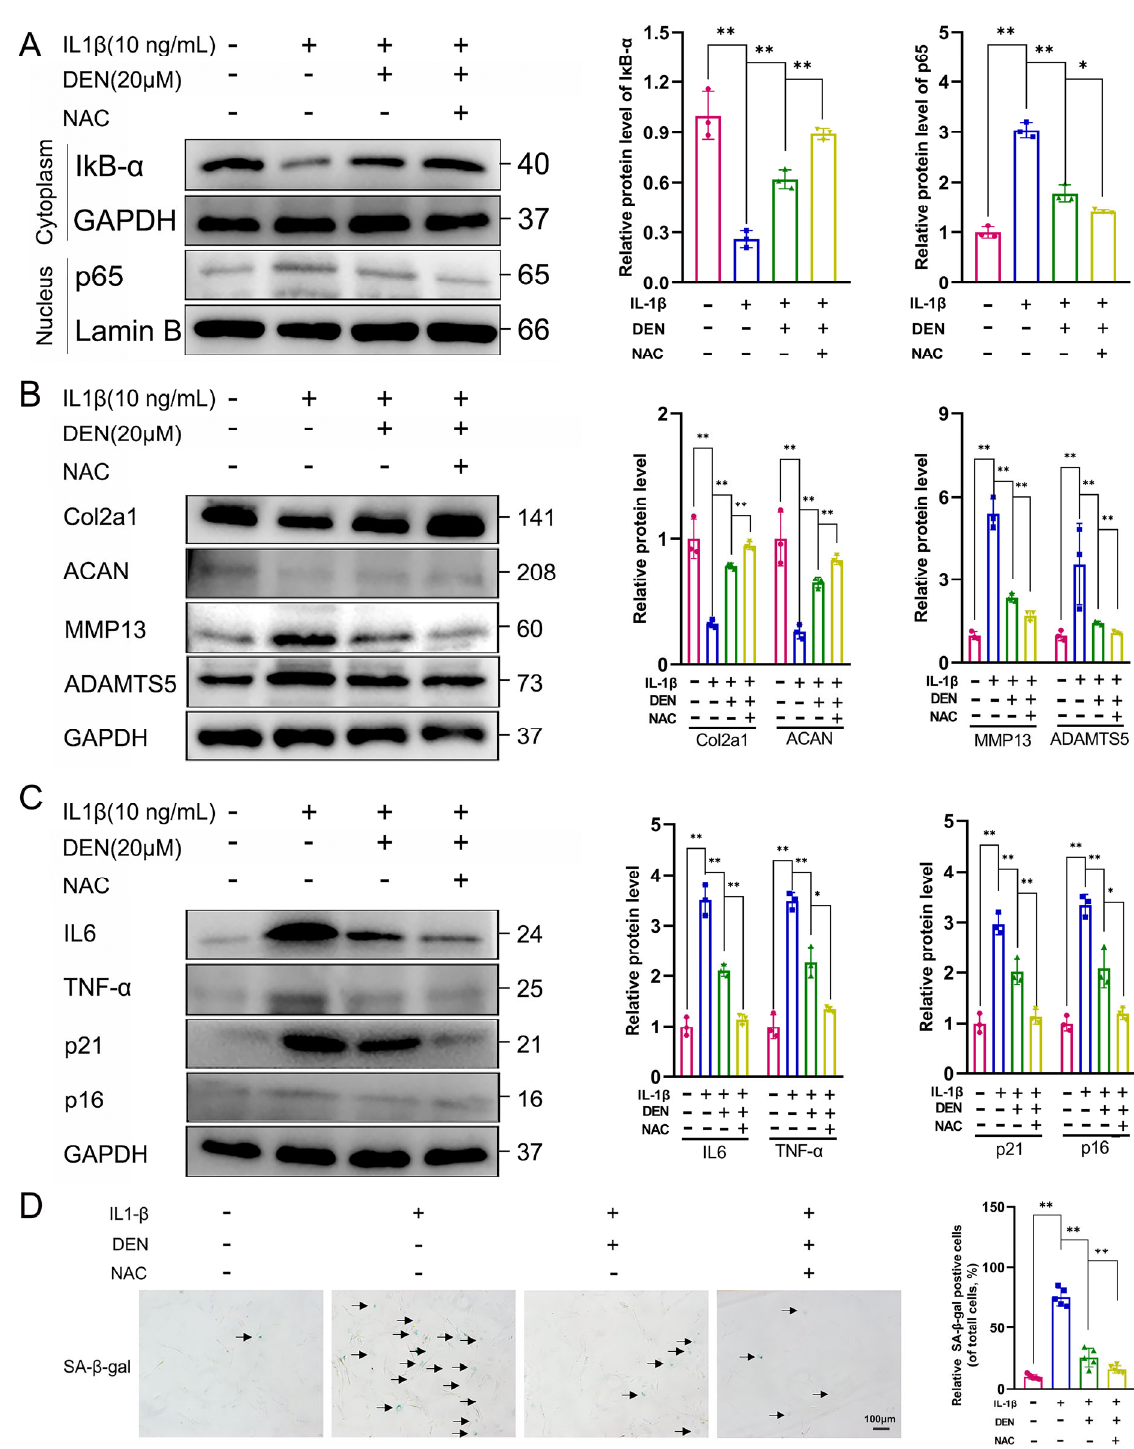
Figure 6. Effect of NAC (ROS inhibitor) on the NF- κ B pathway, extracellular matrix, and senescence phenotype in chondrocytes treated by dendrobine (DEN). ( A ) The protein expressions of I κ B- α and p65 were assessed by Western blotting in NAC-treated chondrocytes, n = 3. ( B ) The protein expressions of Col2a1, aggrecan (ACAN), MMP13, and ADAMTS5 were assessed by Western blotting in chondrocytes treated with NAC, n = 3. ( C ) The protein expressions of IL6, TNF- α , p21, and p16 were assessed by Western blotting in chondrocytes treated with NAC, n = 3. ( D ) SA- β -gal staining in NAC ‐ treated chondrocytes, n = 5. The values presented are the means ± SD. * p < 0.05, ** p < 0.01.